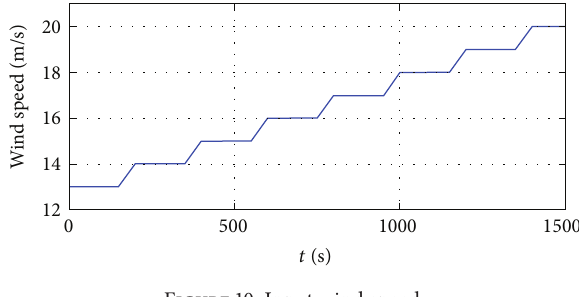
Figure 10: Input wind